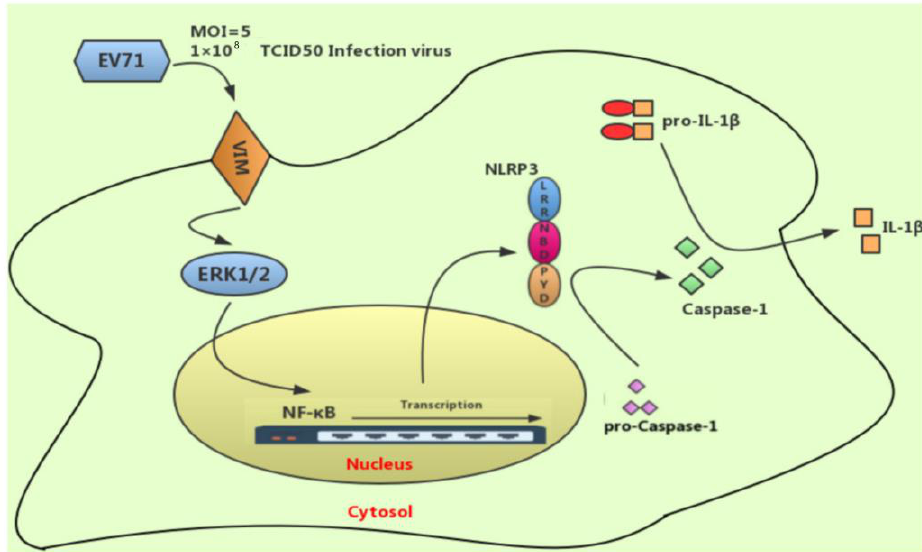
Figure 7. A proposed schematic of EV71-mediated NLRP3 inflammasome activation via VIM-ERK-NF- κB pathway in U251 cells.